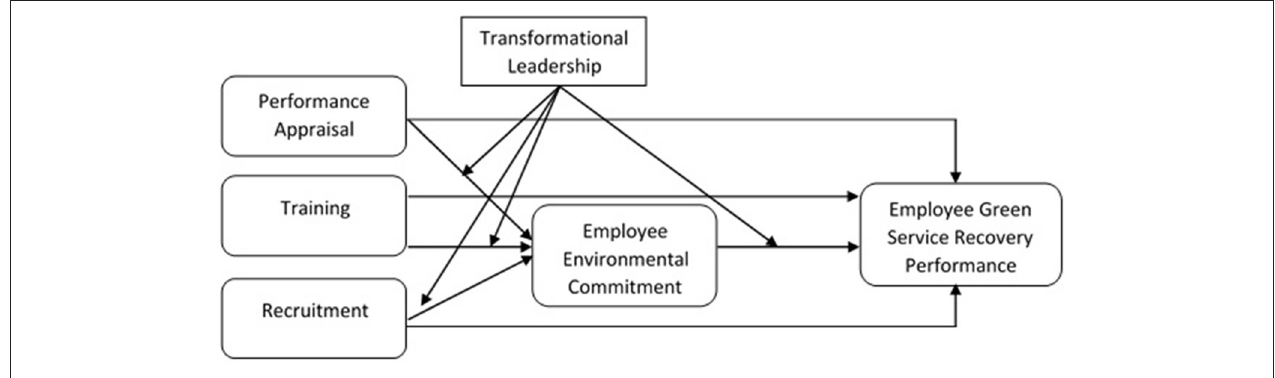
FIGURE 1 | Conceptual framework by authors.